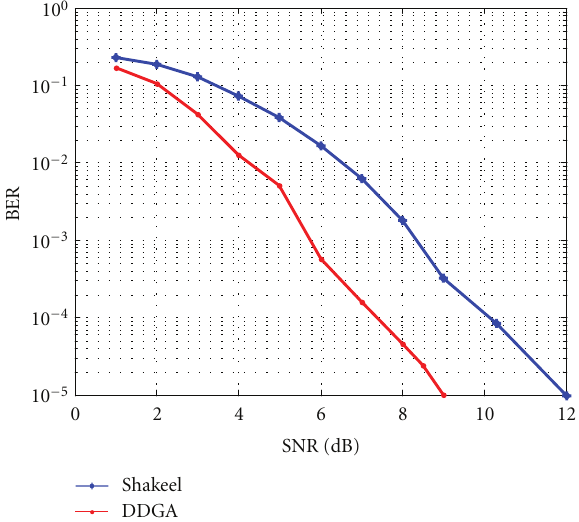
Figure 30: Performances of DDGA, and Shakeel algorithms for QR (103,52,19) code over